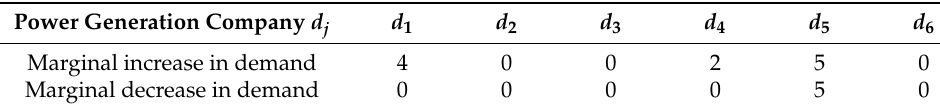
Table 5. Marginal demand change of stable matching.